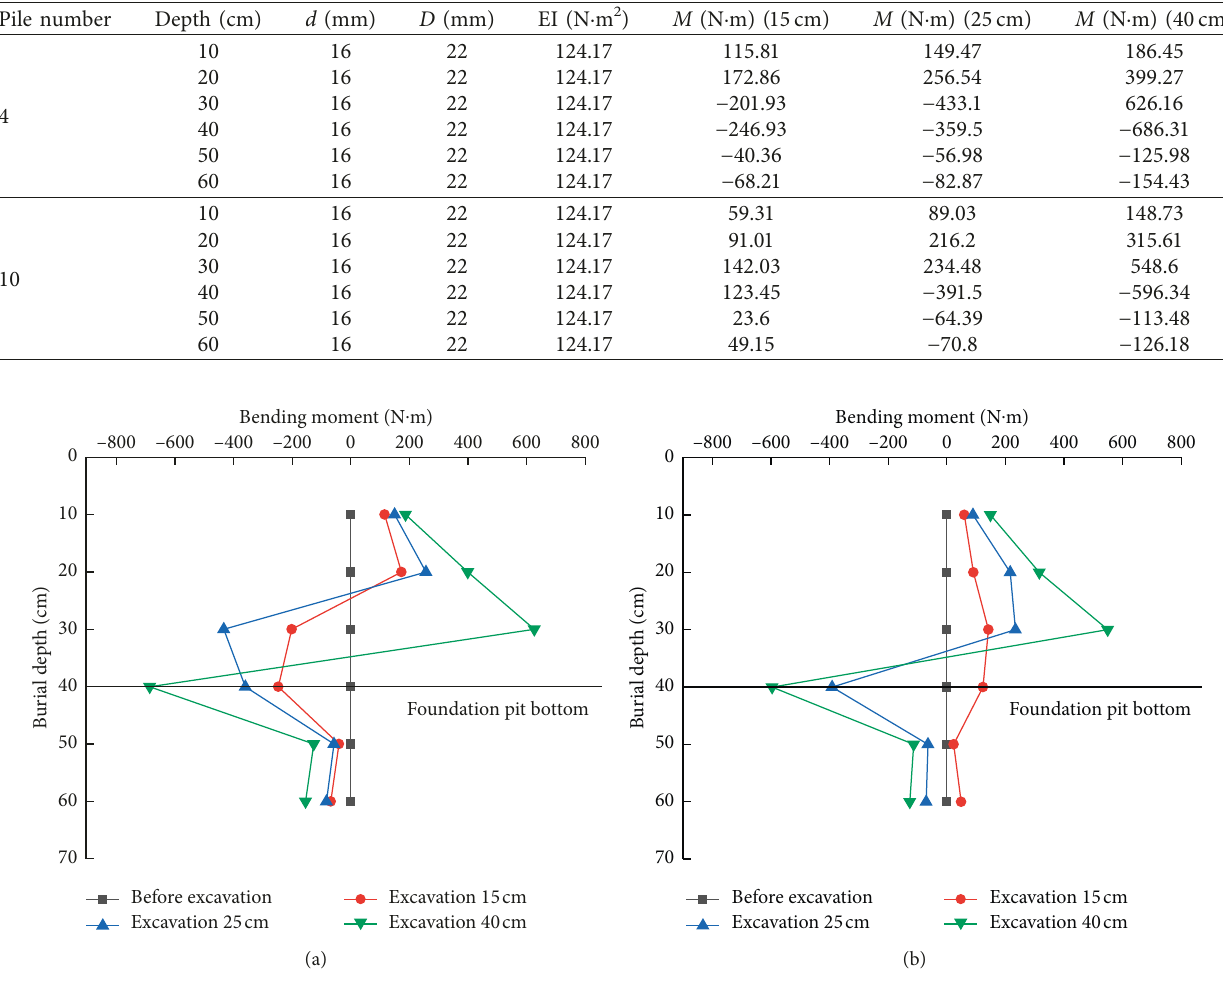
Figure 11: Moment curves of each pile body during excavation. (a) Pile 4. (b) Pile